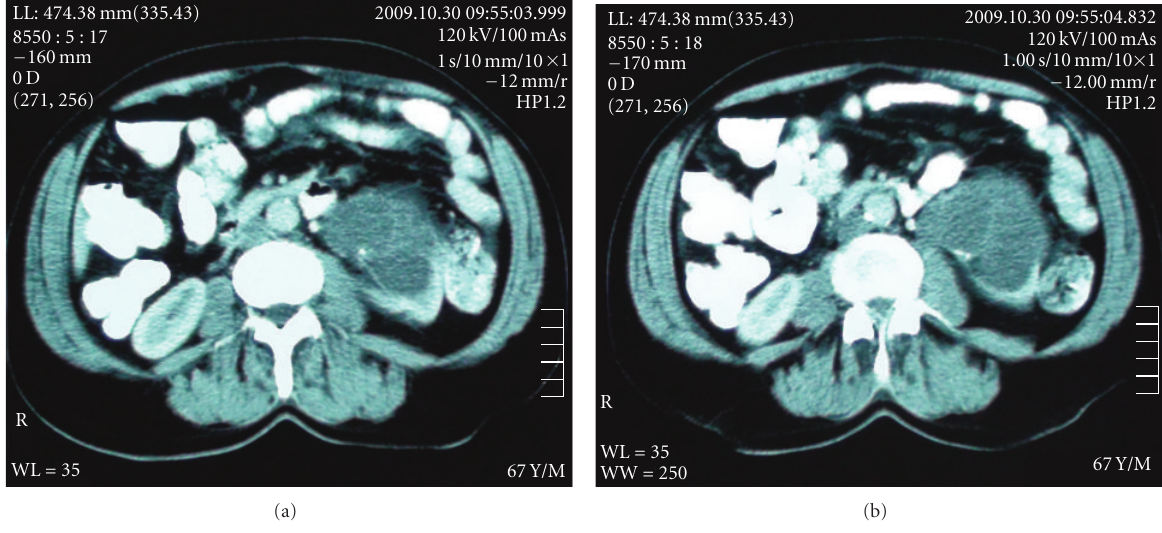
Figure 1: Cystic lesion, originated from renal pelvis, and containing multilocular cystic structure divided by contrasted septate and covered with calcified wall in 7 × 6 × 6cm size (Bosniak-IIF), was displayed on contrast-enhanced computerized tomography.